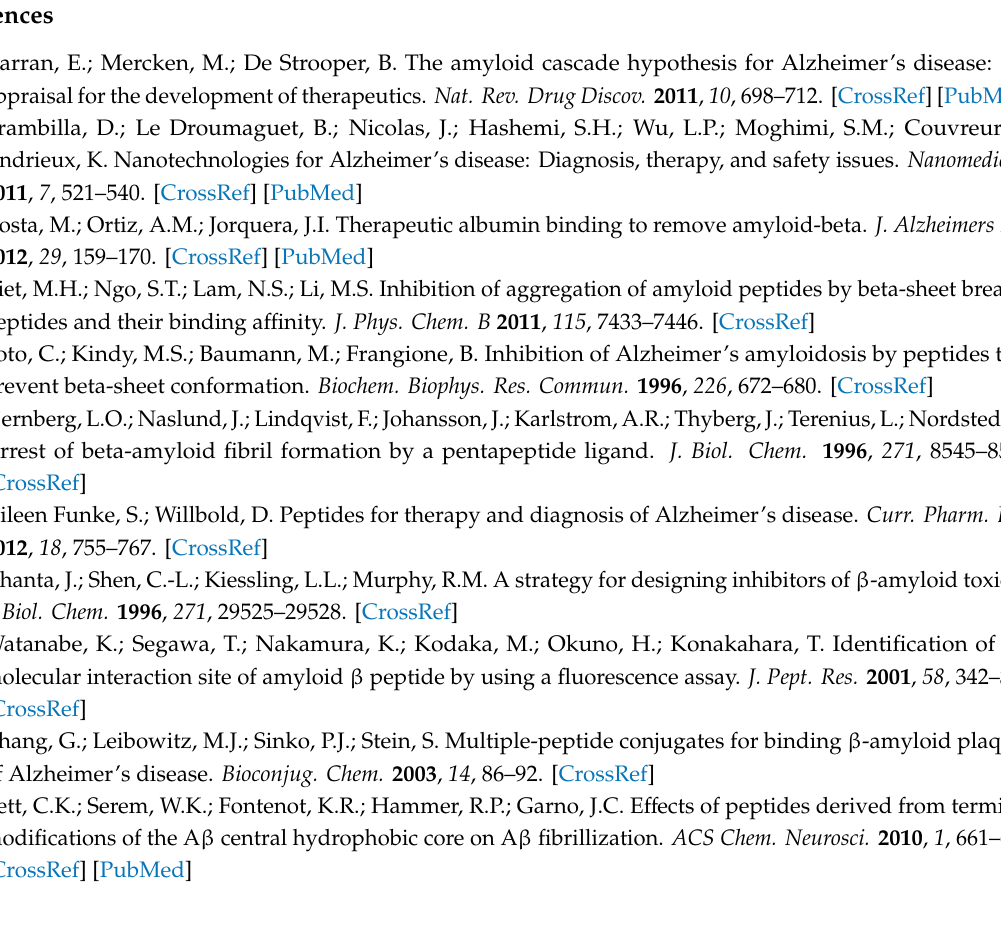
Table S1: Solubility of KLVFF, PLGA, and mix of KLVFF and PLGA in water and suitable organic solvent for nanoprecipitation techniques. Figure S1: Characterization of A β